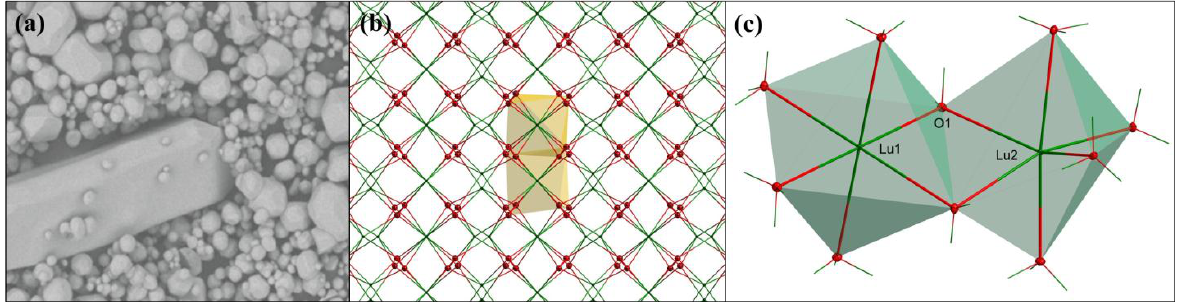
Figure 7. ( a ) The grain of the powder SIII-3 selected for the monocrystalline structural measurements; ( b ) a packing diagram of Lu 2 O 3 . For clarity, only two polyhedra were shown; ( c ) coordination environment of Lu1 and Lu2 in Lu 2 O 3 .